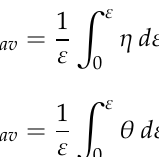
Figure 15. The dependency of effective strain on the Lode angle parameter in virtual sensors located in the axis of a sample with the length l 0 = 90 mm, subjected to rotational compression.